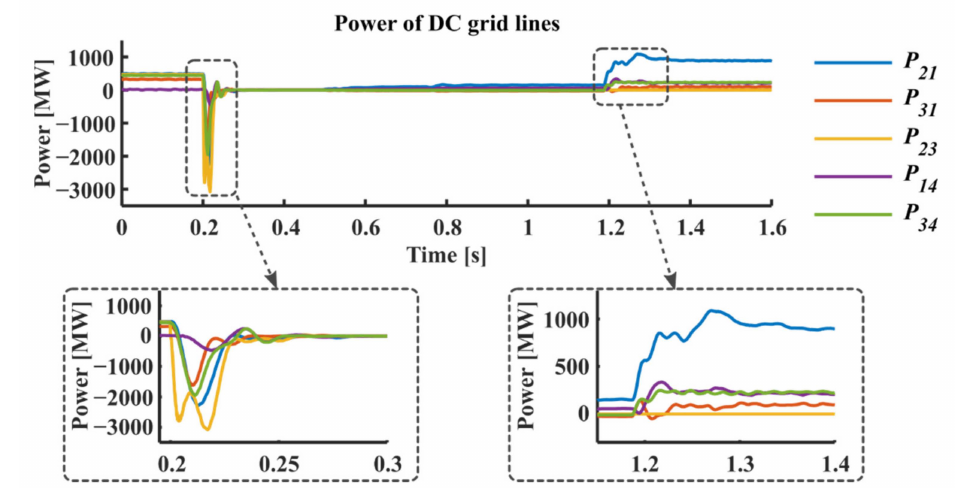
Figure 16. Power flow in the DC transmission lines with fault at location